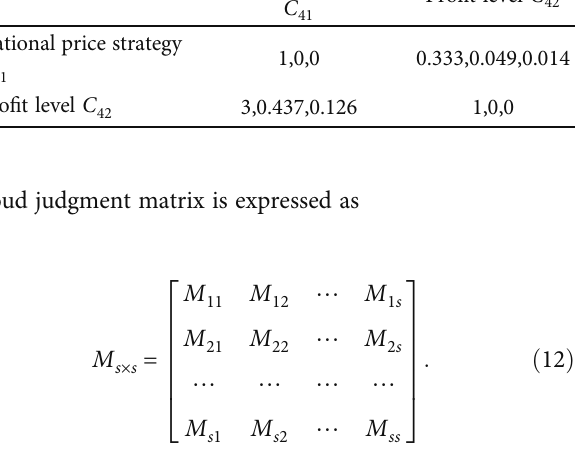
Table 7: The judgment matrix of B